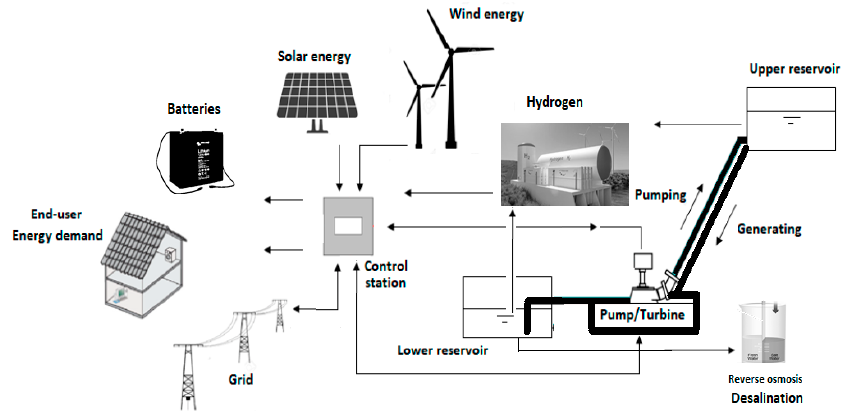
Figure 1. PHES hybrid solution with hydrogen production and desalination.